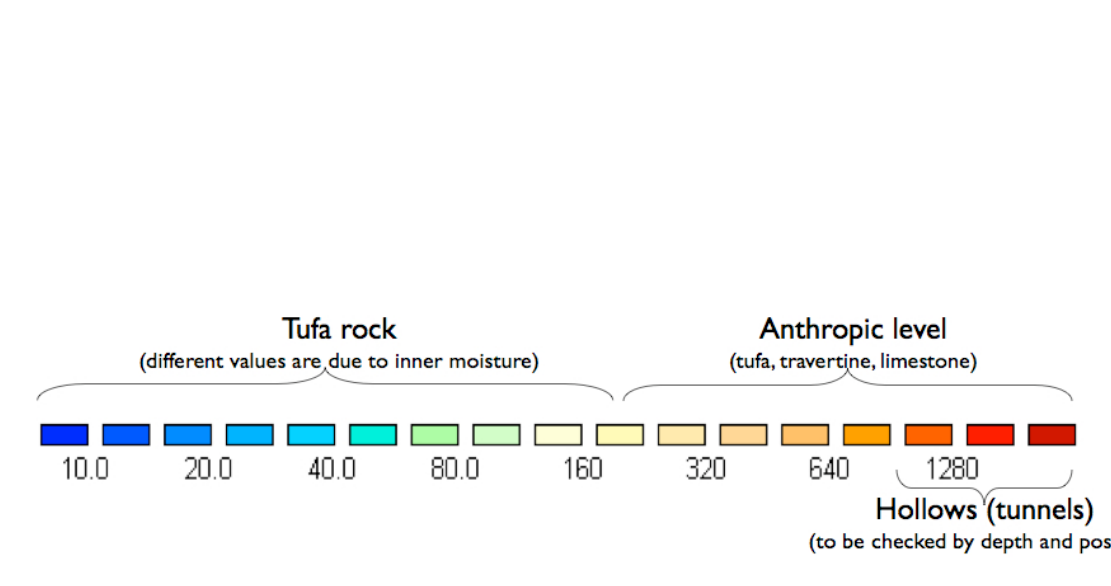
Fig. 6. The last accessible part of tunnel C, where it splits in two different galleries (photo M. De Franceschini).